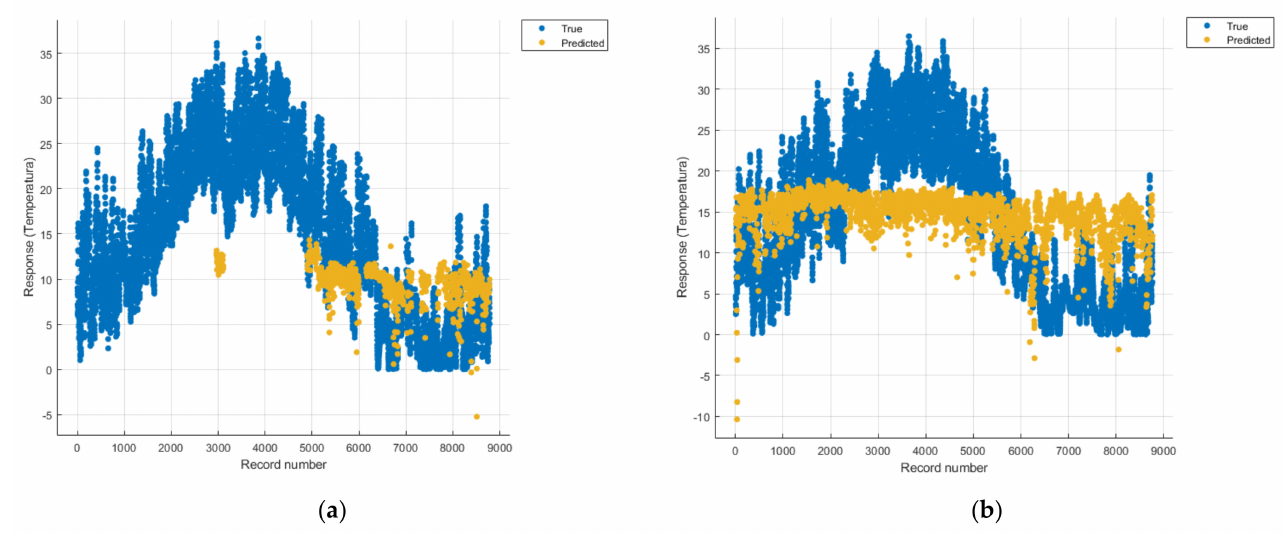
Figure 8. Prediction considering all pollutants—Linear Regression. ( a ) March 2019–February 2020, ( b ) March 2020– February 2021.